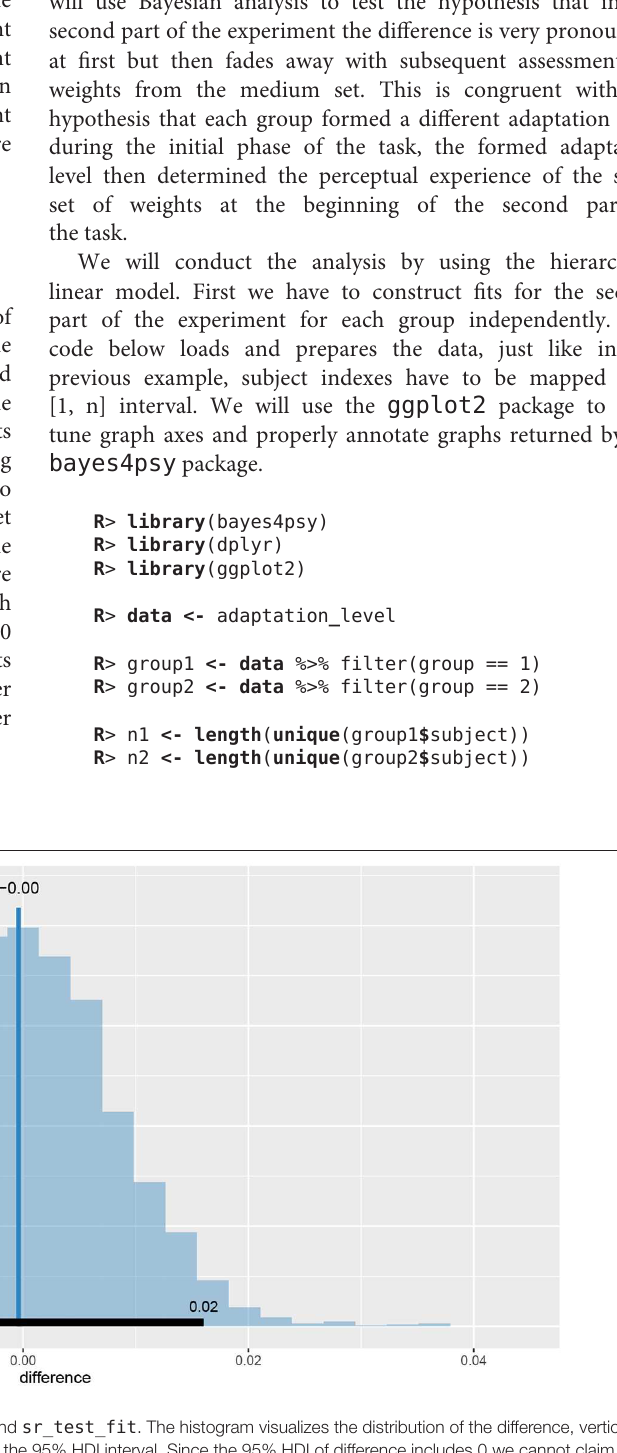
Frontiers in Psychology |